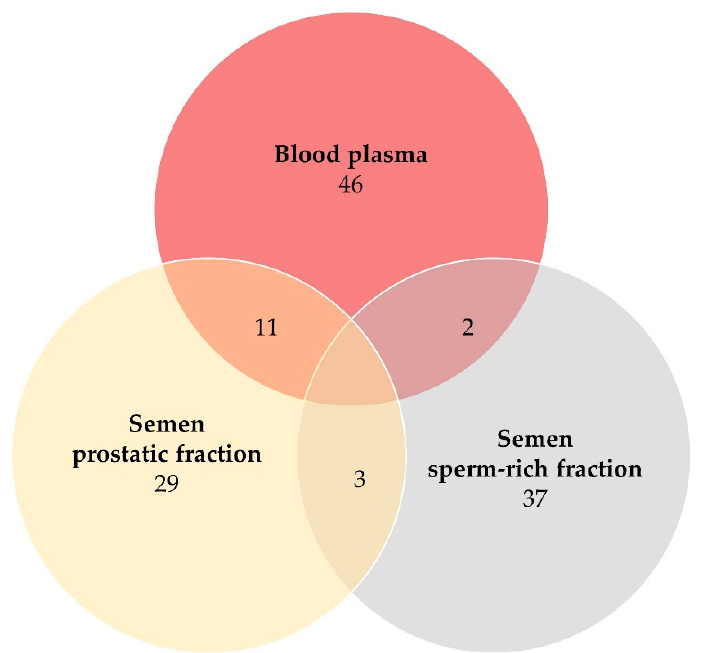
Figure 2. Venn diagram of numbers of proteins detected in blood plasma (dark red), semen sperm- rich fraction (grey), and semen prostatic fraction (yellow) samples from Beagle-breed dogs (protein identification by LC-MS/MS). Table 2. Proteins simultaneously identified in two tissues among those assessed: blood plasma (BP), semen sperm-rich fraction (SF), and semen prostatic fraction (PF) from Beagle-breed dogs (protein identification by LC-MS/MS).